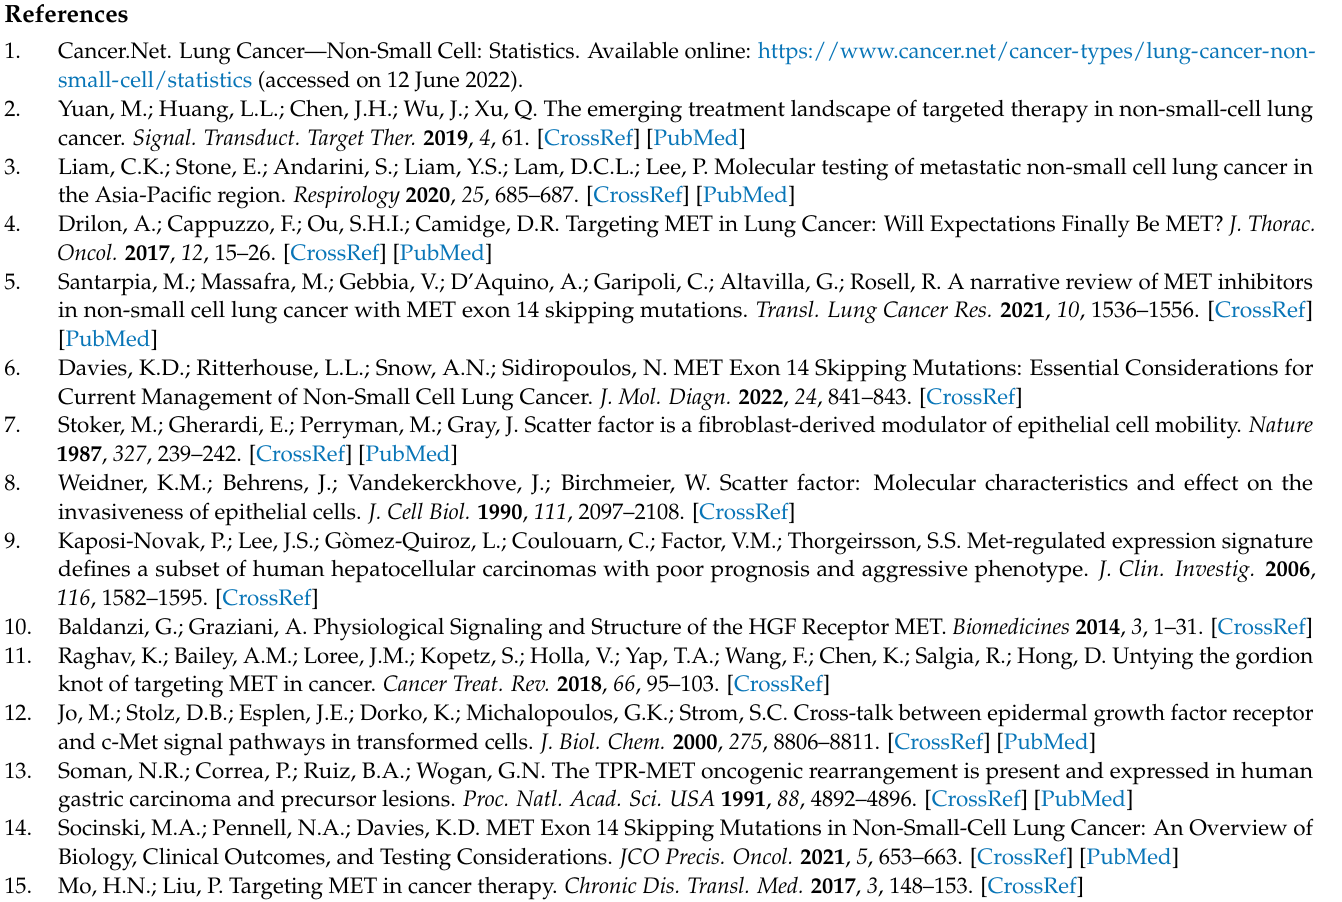
Table S3: Safety results of SAVANNAH